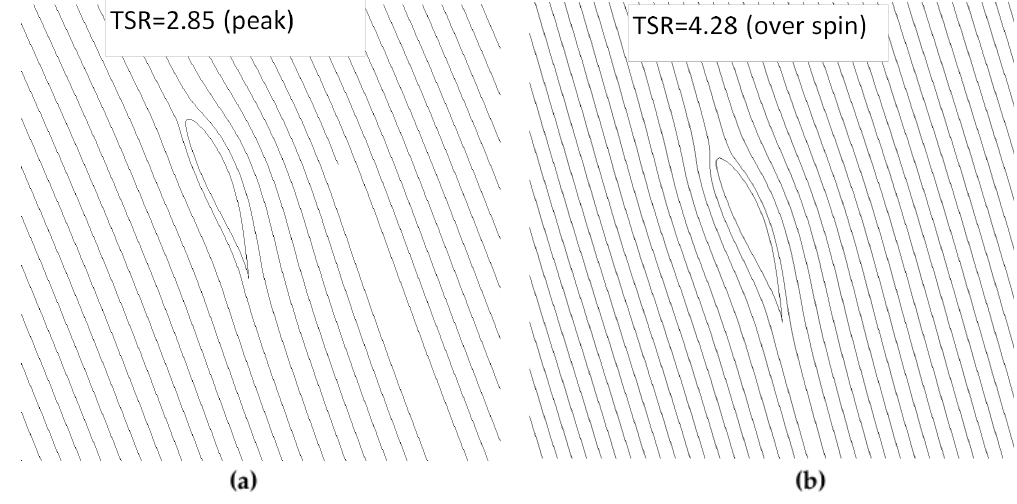
Figure A2. Streamlines at 70% span for the 35 ◦ root pitch turbine in the tube. ( a ) Peak TSR; ( b ) Over spin.